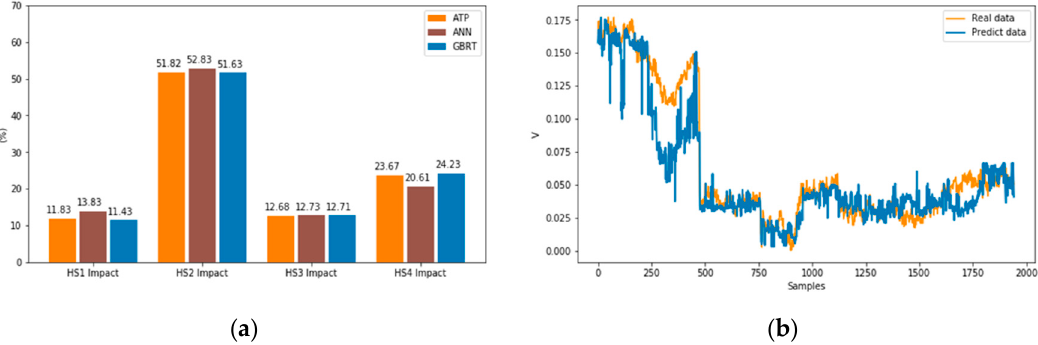
Figure 4. ( a ) The impact factor of each nonlinear load represented in the IEEE-13 bus system studied by evaluated techniques and ( b ) Comparing real data (ATP calculated fifth harmonic voltage magnitudes - in orange) at bus B03 with their estimates obtained by the GBRT in blue.